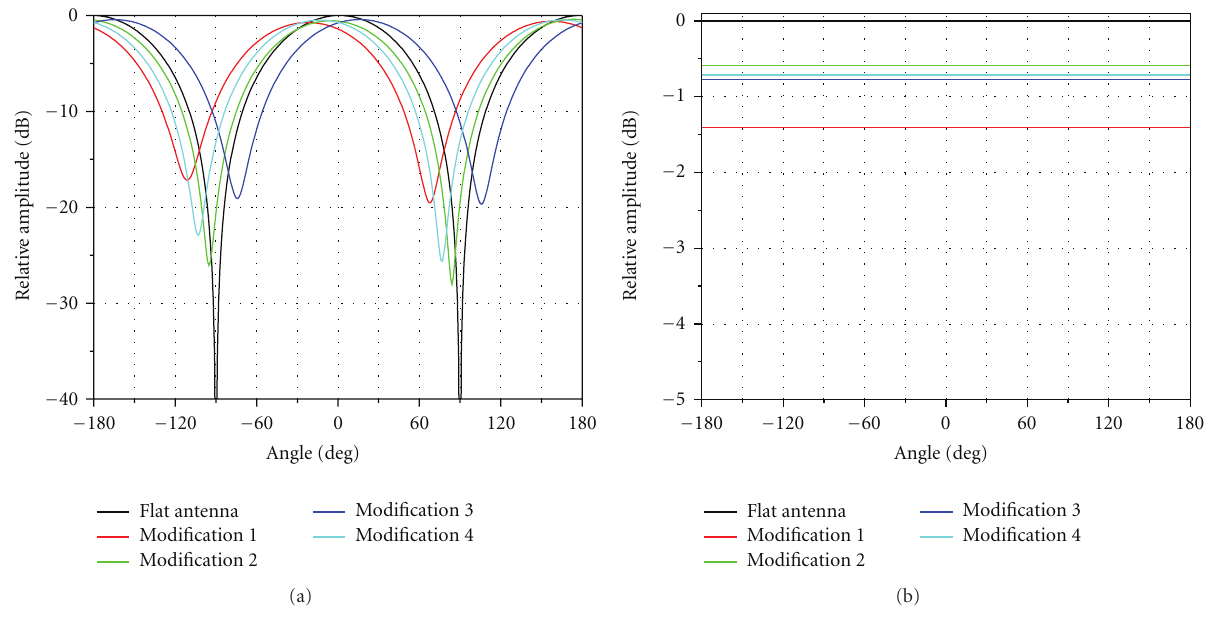
Figure 4: Radiations patterns for the proposed fractal antenna: (a) radiation pattern in E-plane, (b) radiation pattern in H-plane. the angle of the printhead during printing. In the case